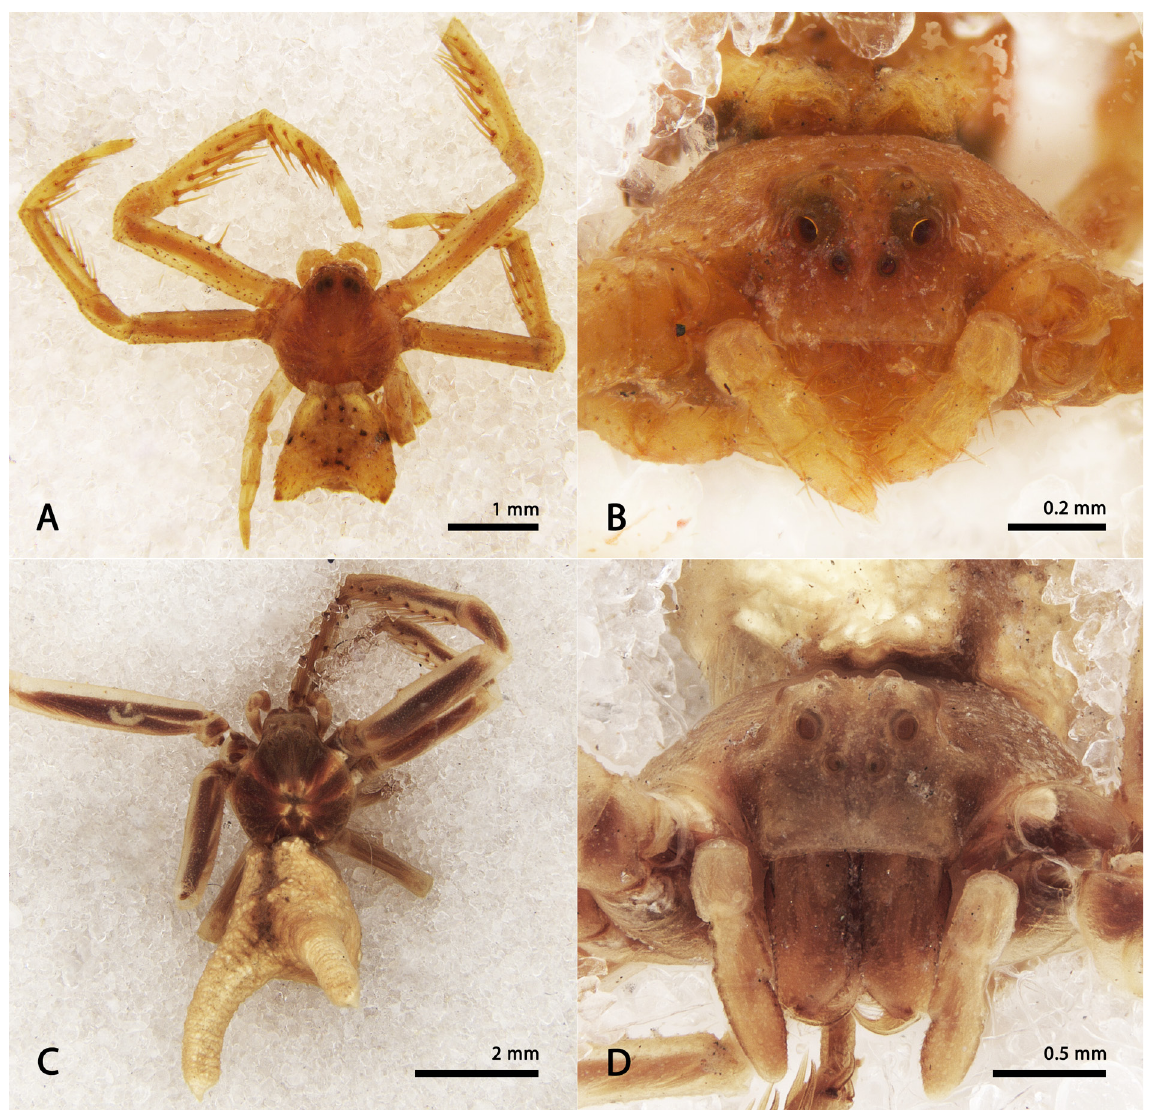
Fig. 24. A–B . Holotype of Stephanopis borgmeyeri Mello-Leitão, 1929. Holotype (MNRJ 917). A . Habitus, dorsal view. B . Front. C–D . Stephanopis furcillata Keyserling, 1880. Holotype (ZMHB 2406). C . Habitus, dorsal view. D .